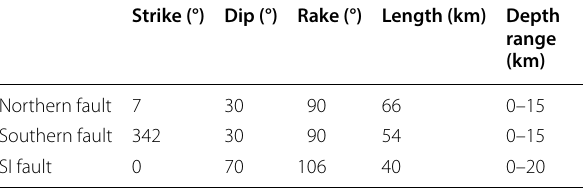
Table 1 Source parameters for the three target faults: the northern, southern, and SI faults (Fig. 1 black, blue, and green